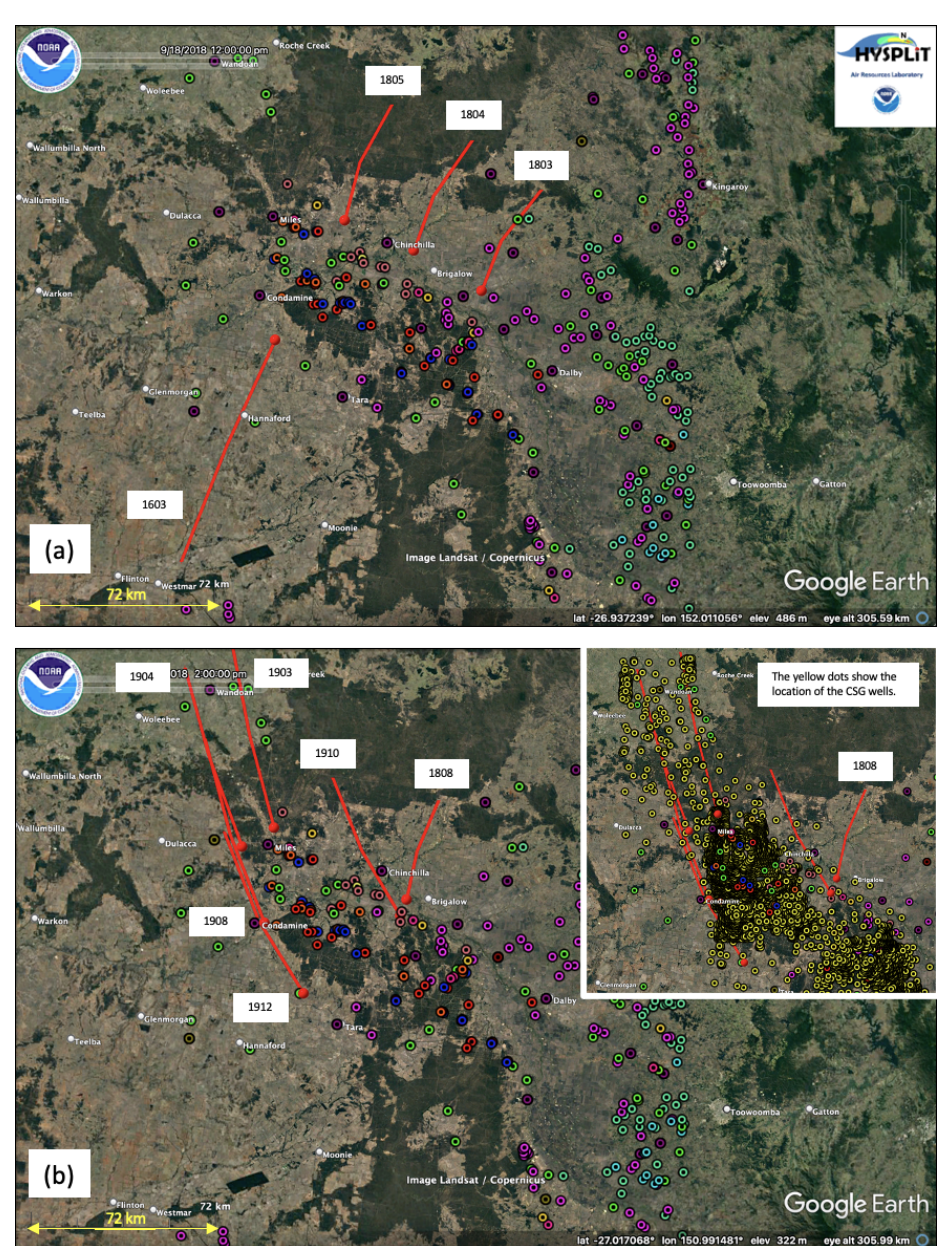
Figure A4. Two-hour HYSPLIT back-trajectory path lines (red) for the points used in the grazing cattle Keeling-model regression anal- ysis. (a) HYSPLIT back trajectories grazing cattle > 50% BU inventory, altitude 250–350ma.g.l. (b) HYSPLIT back trajectories grazing cattle > 50% BU inventory, altitude 100–200ma.g.l. Refer to Fig. A1 for the point source colour key (image © Google